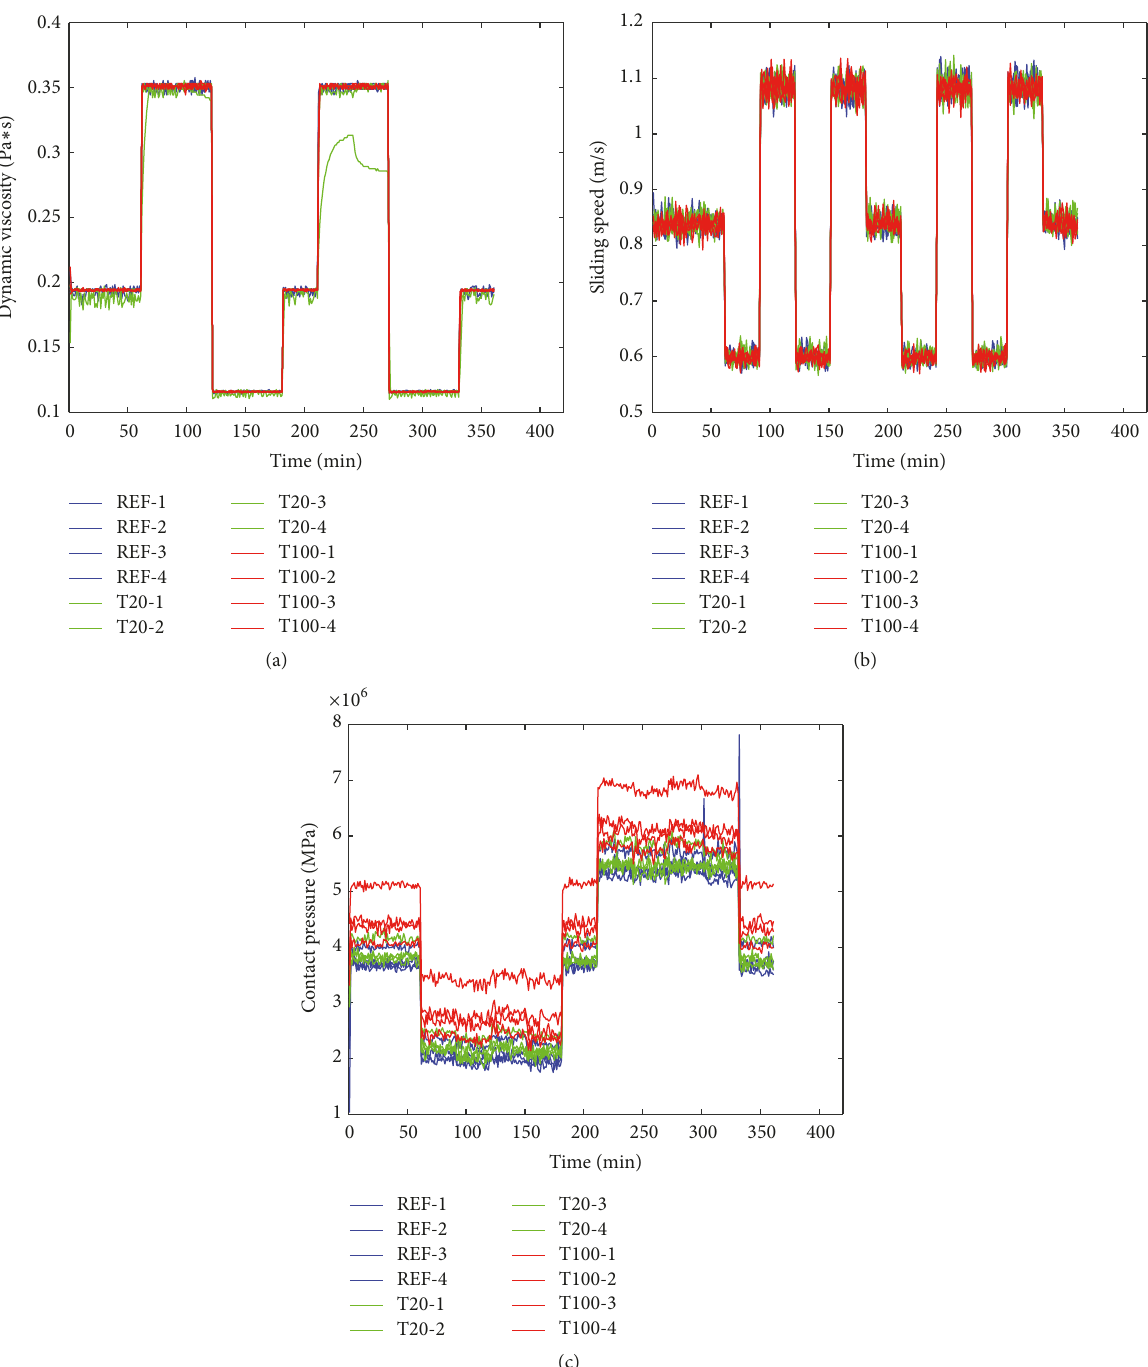
Figure 6: Measurement of input signals in experiments. (a) Dynamic viscosity. (b) Sliding speed. (c) Contact pressure.